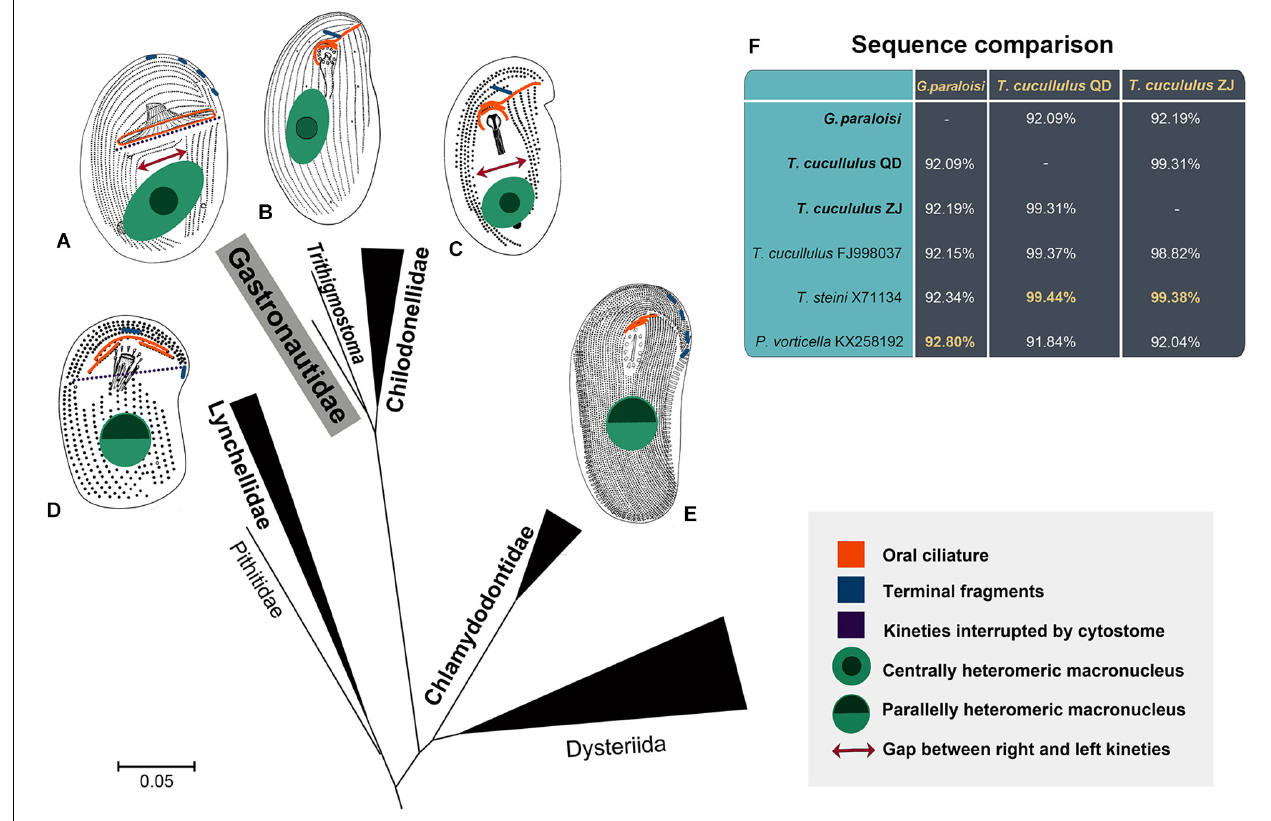
FIGURE 6 | The illustrations display key morphological characteristics (indicated by different colors and shapes) of Chlamydodontida families (A–E) . The scale bar represents 5 substitutions per 100 nucleotide positions. (A) Gastronautidae ( Gastronauta ). (B) Trithigmostoma . The heteromeric centralization of the macronucleus is sometimes inconspicuous. (C) Chilodonellidae ( Chilodonella ). (D) Lynchellidae ( Lynchella ). (E) Chlamydodontidae ( Chlamydodon ). (F) Comparison of closely related sequences. The greatest similarities to the three sequences in the present work are